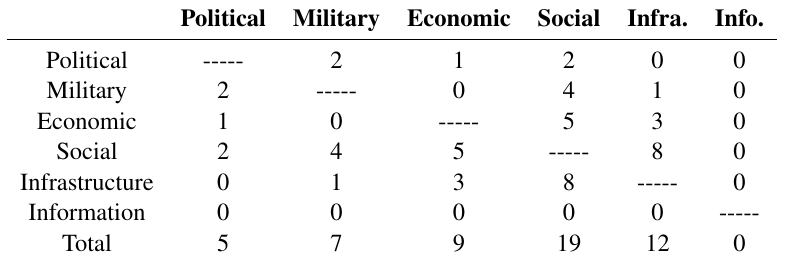
Summary of relationships where plans and policies were proposed to address critical uncertainties.